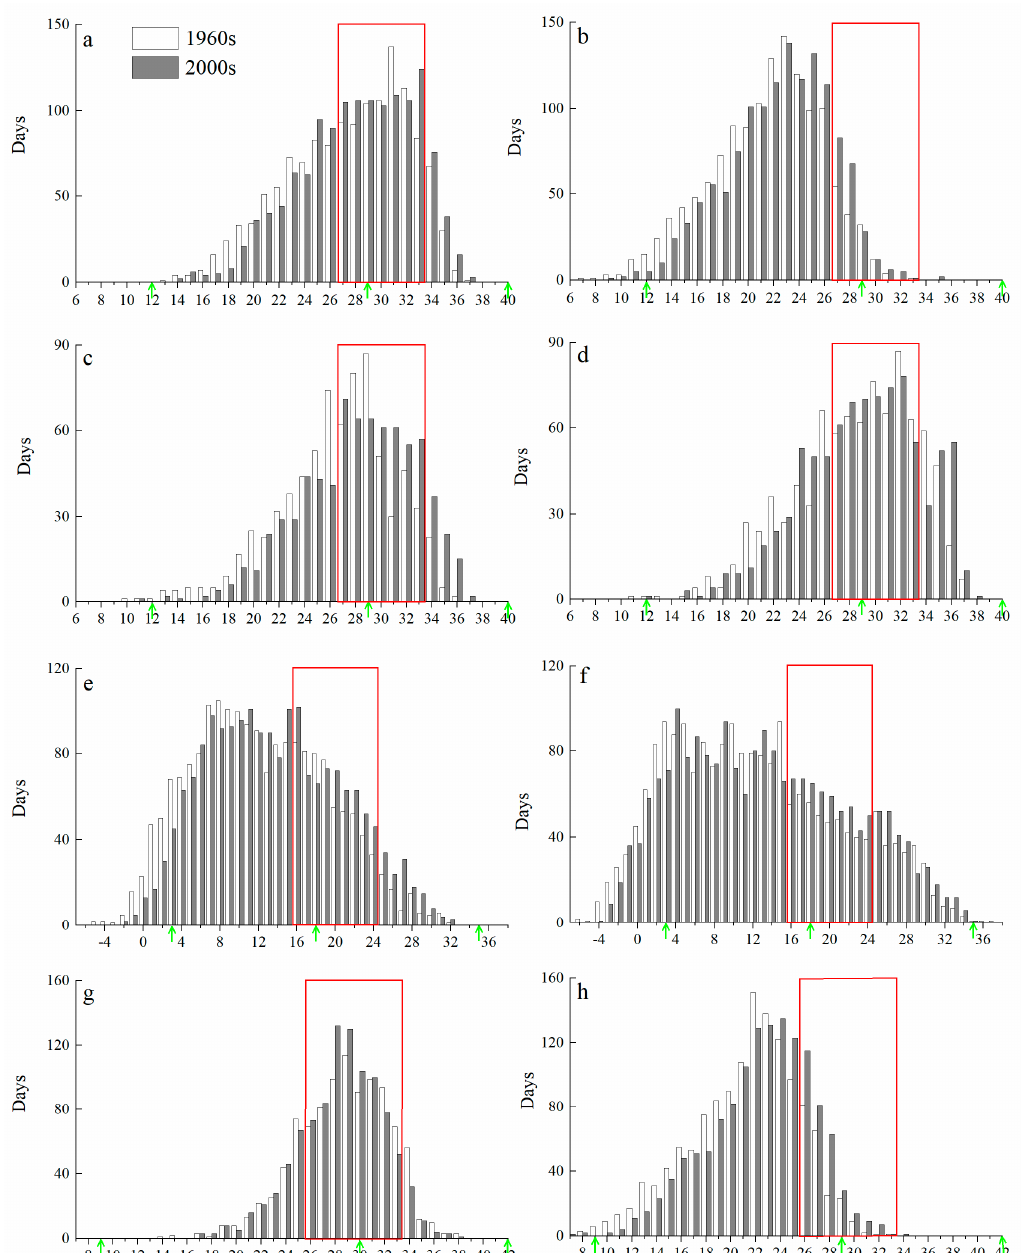
Figure 2. Frequency distributions of daytime temperatures for the 1960s (1960–1969) and 2000s (2000–2009) for the whole growing seasons of different crops at different sites: ( a ) rice, Changshu; ( b ) single rice, Sanjiang; ( c ) early rice, Taoyuan; ( d ) late rice, Taoyuan; ( e ) winter wheat, Changshu; ( f ) winter wheat, Fengqiu; ( g ) summer maize, Fengqiu; ( h ) spring maize, Hailun. The three green arrows in each graph represent the base, optimum and maximum temperatures, respectively, for crop photosynthesis, and the red rectangles highlight ranges of the optimum temperatures for crop photosyn- thesis.